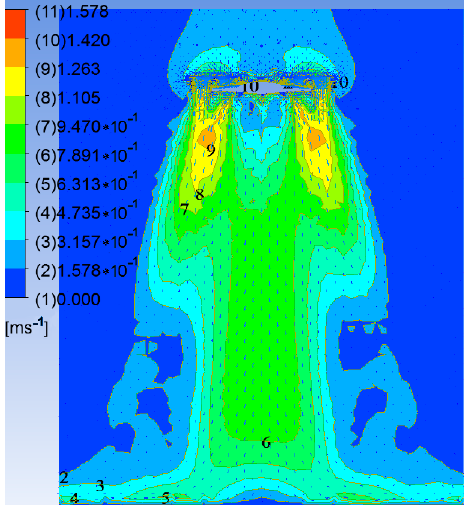
Figure 7. Velocity vector distribution for the down-wash flow fields on the Z - Y section.